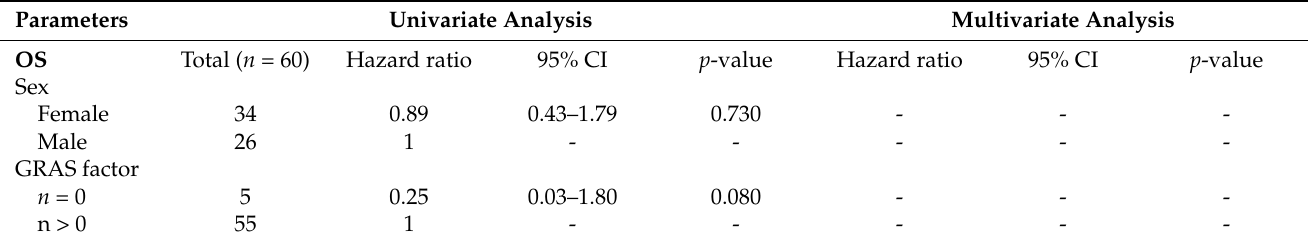
Table 4. Univariate and multivariate analysis for Overall Survival (OS) and Time to second-line Treatment initiation